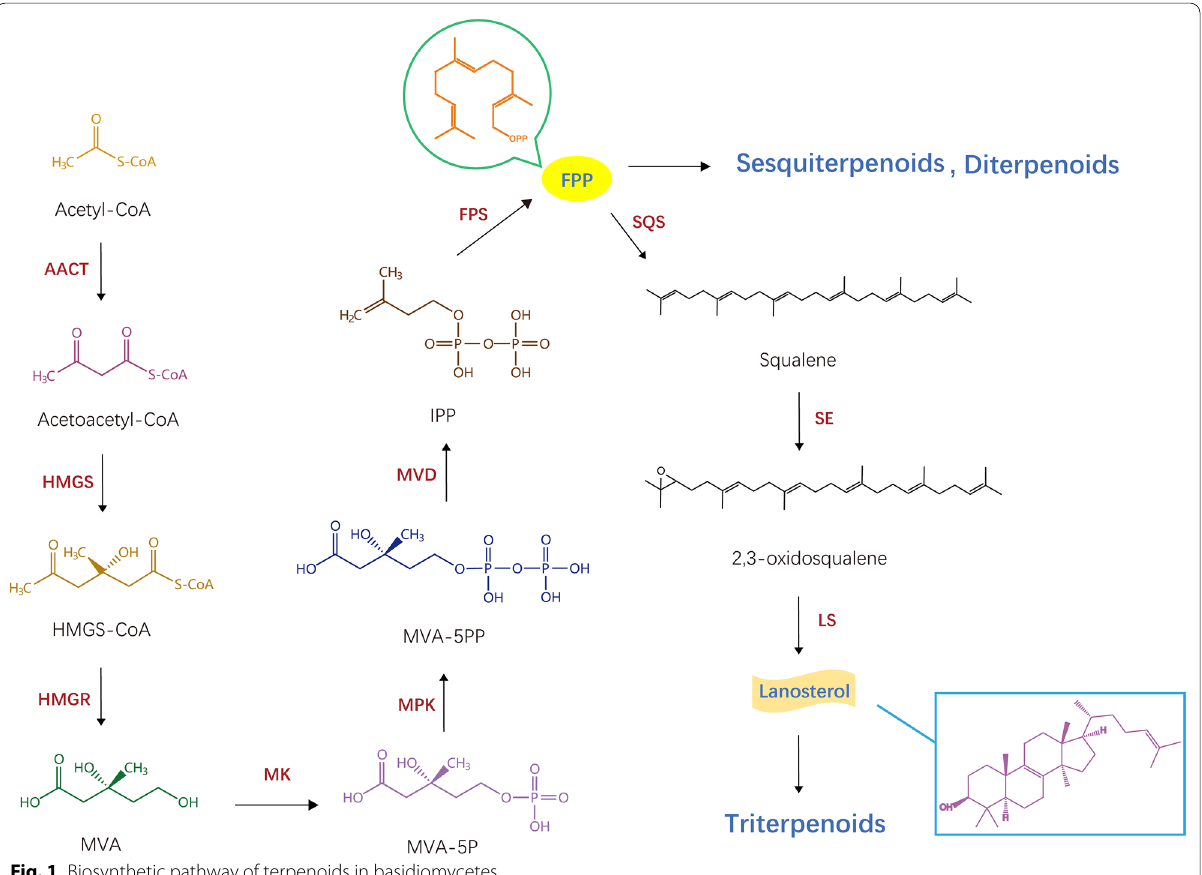
Fig. 1 Biosynthetic pathway of terpenoids in